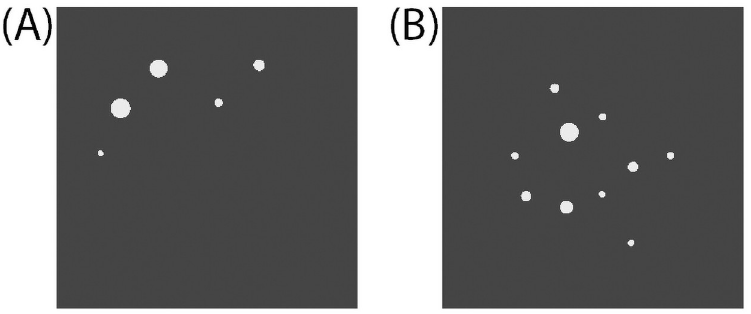
Fig 1. Sample stimuli in the pairwise numerosity comparison task. A: Example array for numerosity 5. B: Example array for numerosity 10. The stimuli pictured exemplify a representation of the “large” pair 5–10.